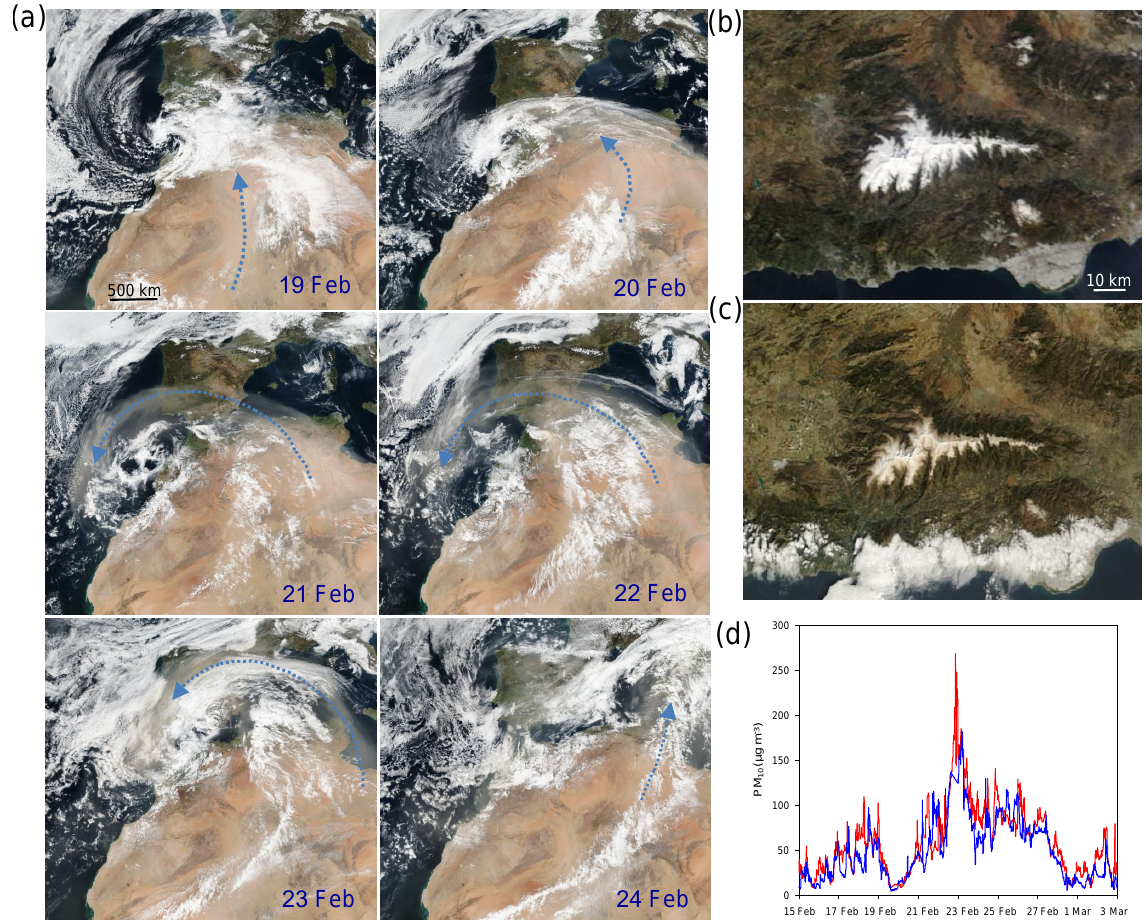
Figure 1. The extreme Saharan dust and red rain event. (a) NASA SUOMI NPP/VIIRS true color images of the Iberian Peninsula and northern Africa during the days of the extreme red rain event. On 19 February dust plumes were visible over northern Mali, northwestern Niger, and southern–central Algeria, which moved north/northeast, reaching the western Mediterranean on 20 February, and wiping in a counterclockwise movement the southern portion of the Iberian Peninsula on 21 February. On 22 and 23 February dust plumes coming from northern Algeria (and Tunisia) continued to sweep the Iberian Peninsula. Finally, on 24 February, the Saharan dust plume moved towards the central Mediterranean. The blue dashed arrow shows the path of the dust plume. (b–c) NASA’s Terra MODIS true color images of the Sierra Nevada (Spain) (b) before (15 February 2017, 11:30UTC) and (c) after (26 February 2017, 11:30UTC) the extreme Saharan red rain event. Note the brownish color of the snow cap after the red rain event. Images credit: NASA/Earthdata (http//:gibs.earthdata.nasa.gov). (d) Ground-level PM 10 concentration at Granada for the days prior to, during, and after the red rain event (the red and blue lines refer to Almanjayar and Palacio de Congresos stations, respectively). Data from Consejería de Medio Ambiente, Junta de